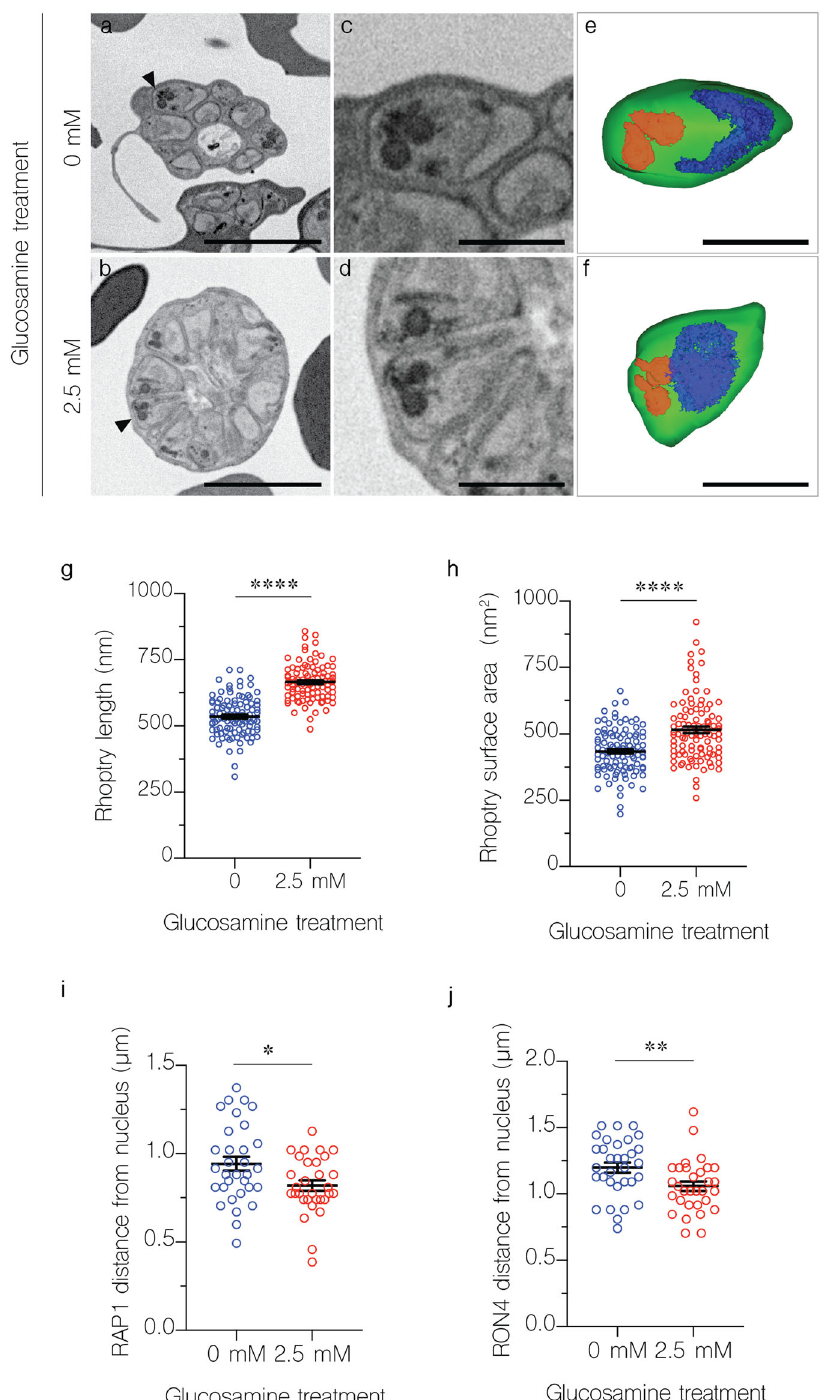
Fig. 7 Knockdown of PfCERLI2 alters rhoptry length and positioning. PfCERLI2 HAGlmS schizonts were matured in the presence of E64 and imaged using array tomography. Inverted backscattered images of untreated ( a ) and GLCN treated ( b ). PfCERLI2 HAGlmS schizonts. c , d Higher magni fi cation images revealing individual merozoites and associated rhoptry pairs indicated by black arrow heads in ( a ) and ( b ). e , f 3D renderings corresponding to the images in ( c ) and ( d ). Colour legend: Merozoite plasma membrane, green; nucleus, blue; rhoptries, red. Scale bars: a and b = 4 µ m; c – f = 1 µ m. Using array tomography, 100 rhoptries for each treatment were analysed to determine their length ( g ) and surface area ( h ). PfCERLI2 HAGlmS schizonts were matured in the presence of E64, stained with antibodies against RAP1 (rhoptry bulb) and RON4 (rhoptry neck), and imaged by Airyscan super-resolution microscopy. The fl ourescence intensity from maximum-intensity projections of RAP1 ( i ) and RON4 ( j ) signals were then measured from the basal end of the nucleus. 32 merozoites for untreated and 31 merozoites for 2.5 mM GLCN treated were measured from a total of 12 schizont images across three biological replicates. Representative images corresponding to this data in Supplementary Fig. 13. Error bars = SEM. * p < 0.05, ** p < 0.01, **** p < 0.0001 by unpaired t